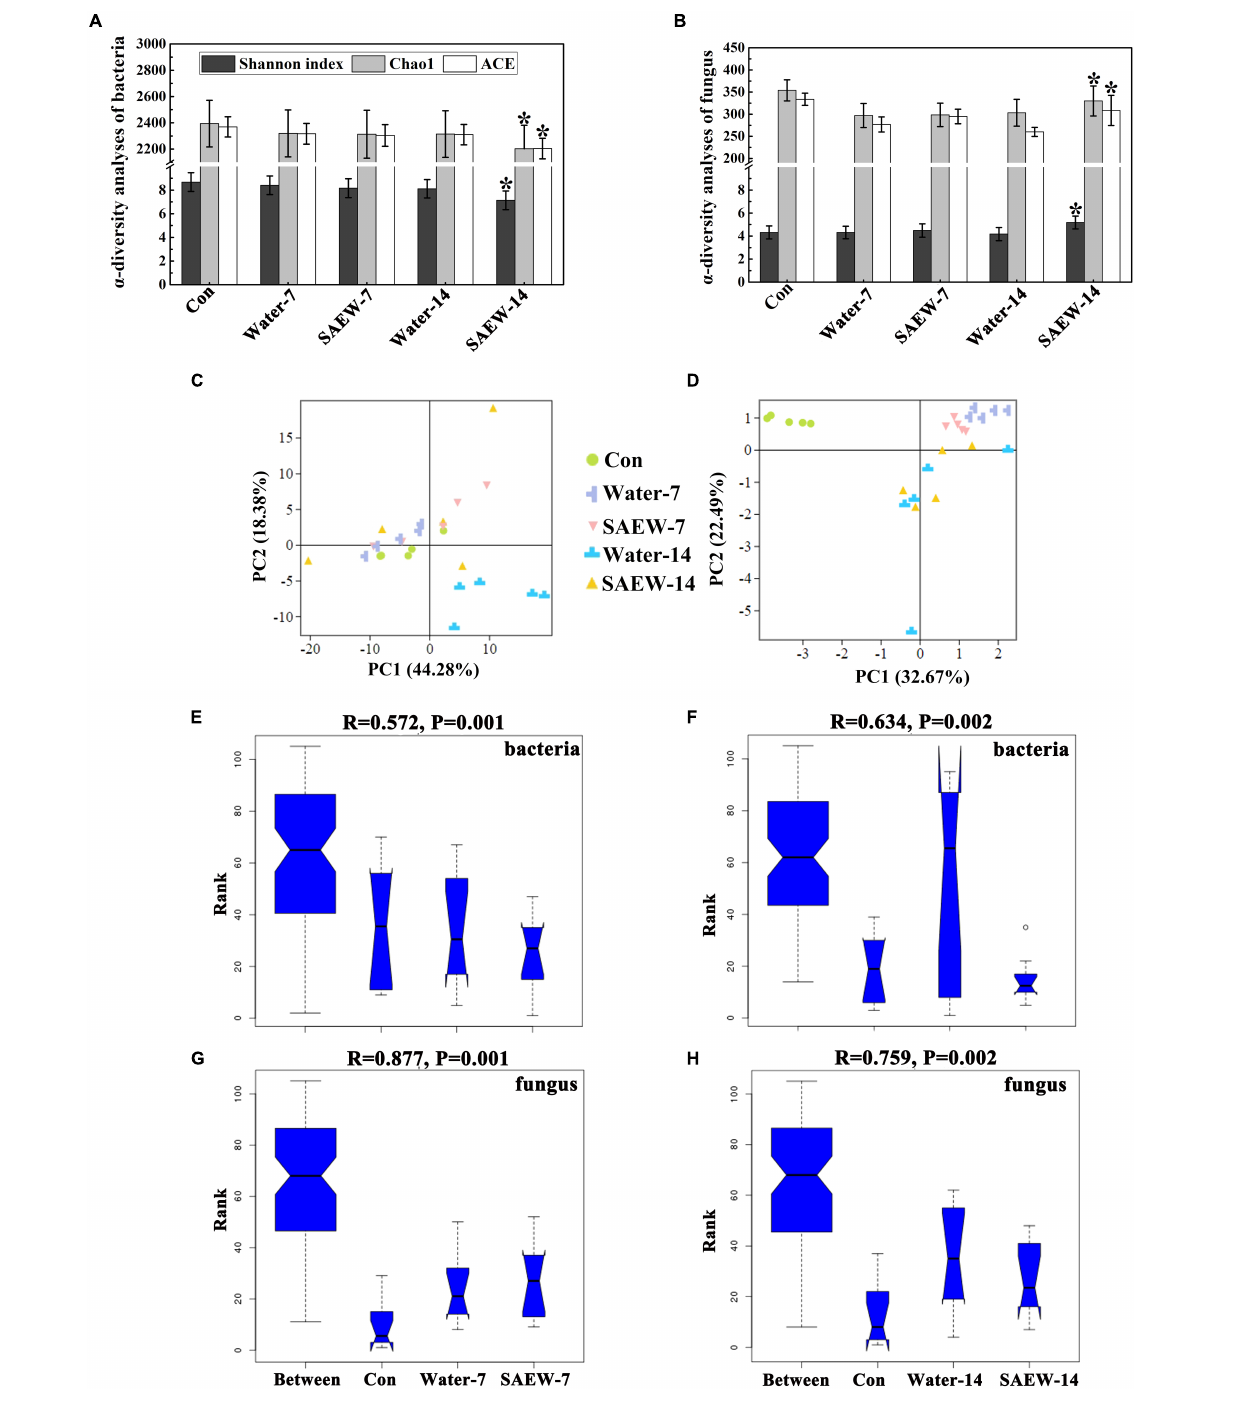
FIGURE 1 | The α - and β -diversity analyses of bacteria and fungus in each treatment. (A,B) show the α -diversity analyses of bacteria and fungus, respectively. (C,D) represent the β -diversity analyses (principal component analysis, PCA) of fungus and bacteria. The PCA plot is based on Bray–Curtis distance at the operational taxonomic unit (OTU) level. Significance was determined by ANOSIM and is shown in panels (E–H) . (E,F) show the bacteria of different treatments in 7 and 14 days. (G,H) show the fungus of different treatments in 7 and 14 days. The soils with different treatments (Con, Water-7, Water-14, SAEW-7, and SAEW-14) were separately collected from 5 replicated pots for each. Con and control (dry soil); Water-7 (the soil irrigated with deionized water for 7 days); Water-14 (the soil irrigated with deionized water for 14 days); SAEW-7 (the soil irrigated with 60 ppm concentration of slightly acidic electrolyzed water for 7 days); SAEW-14 (the soil irrigated with 60 ppm concentration of slightly acidic electrolyzed water for 14